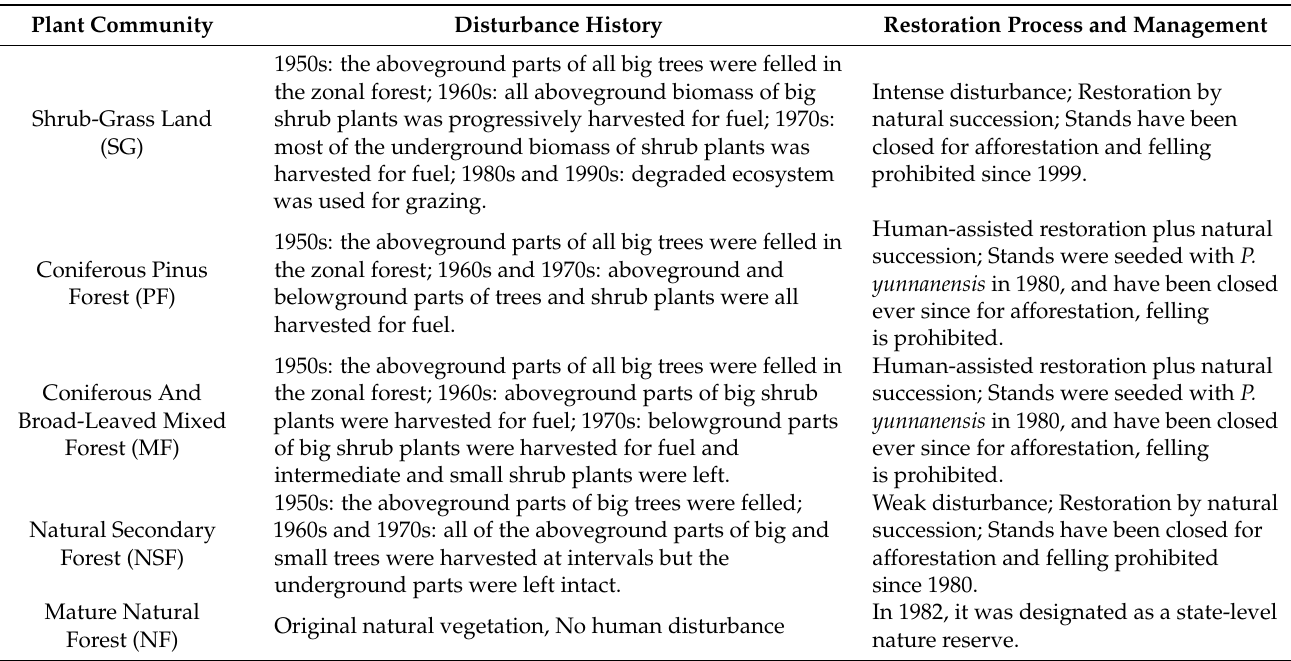
Table A1. Description of disturbances and records of different plant